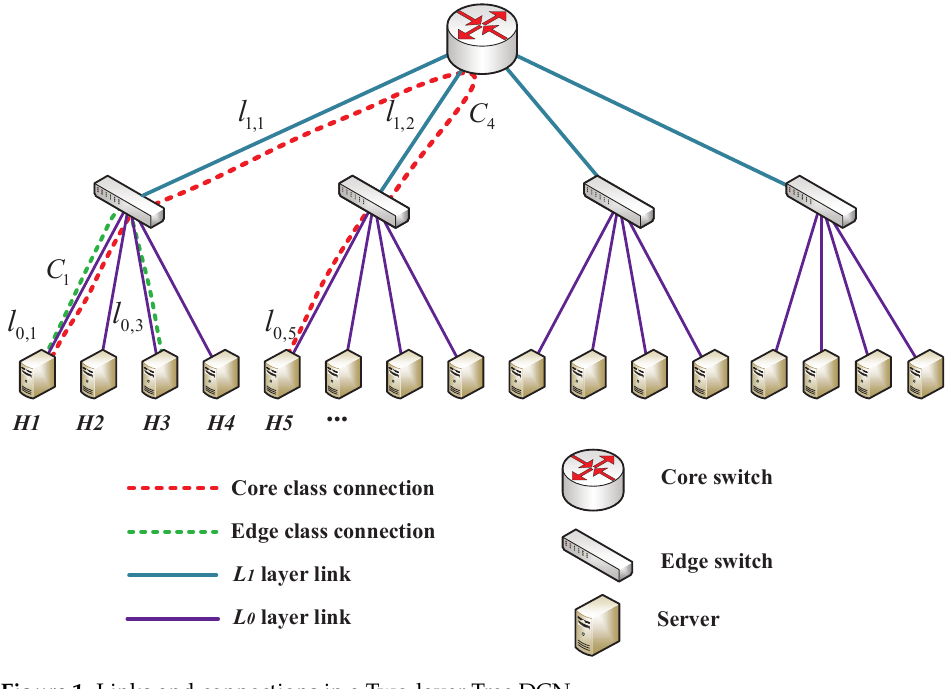
Figure 1. Links and connections in a Two-layer Tree